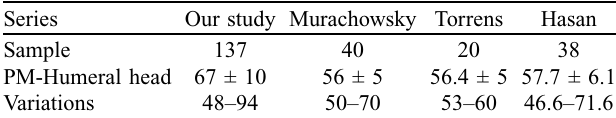
Table 3. Results of humeral height